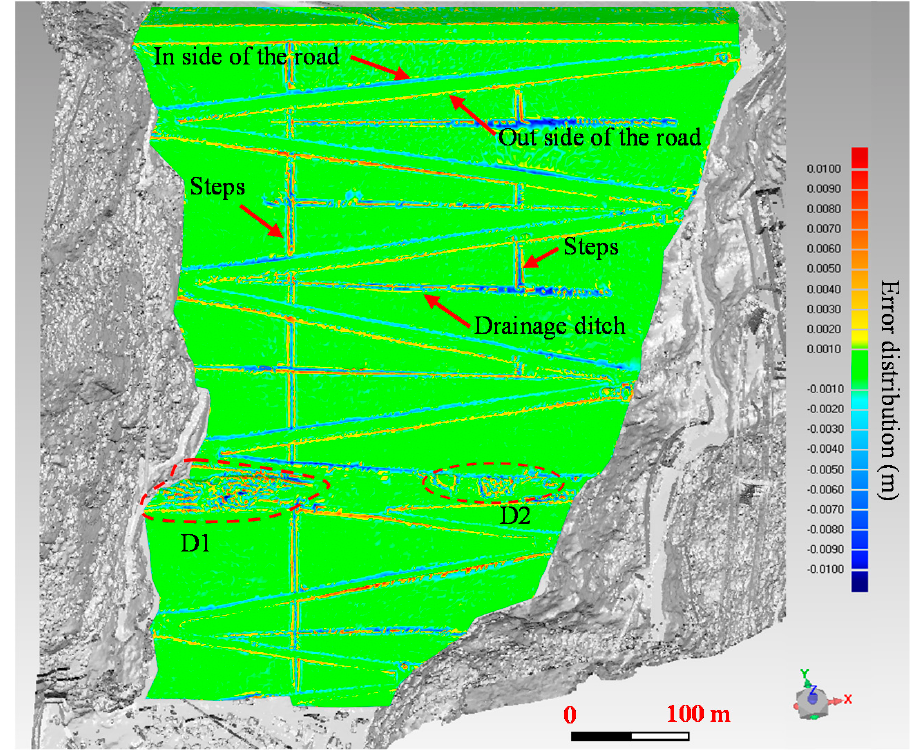
Figure 11. Error distribution in the NURBS modeling process.